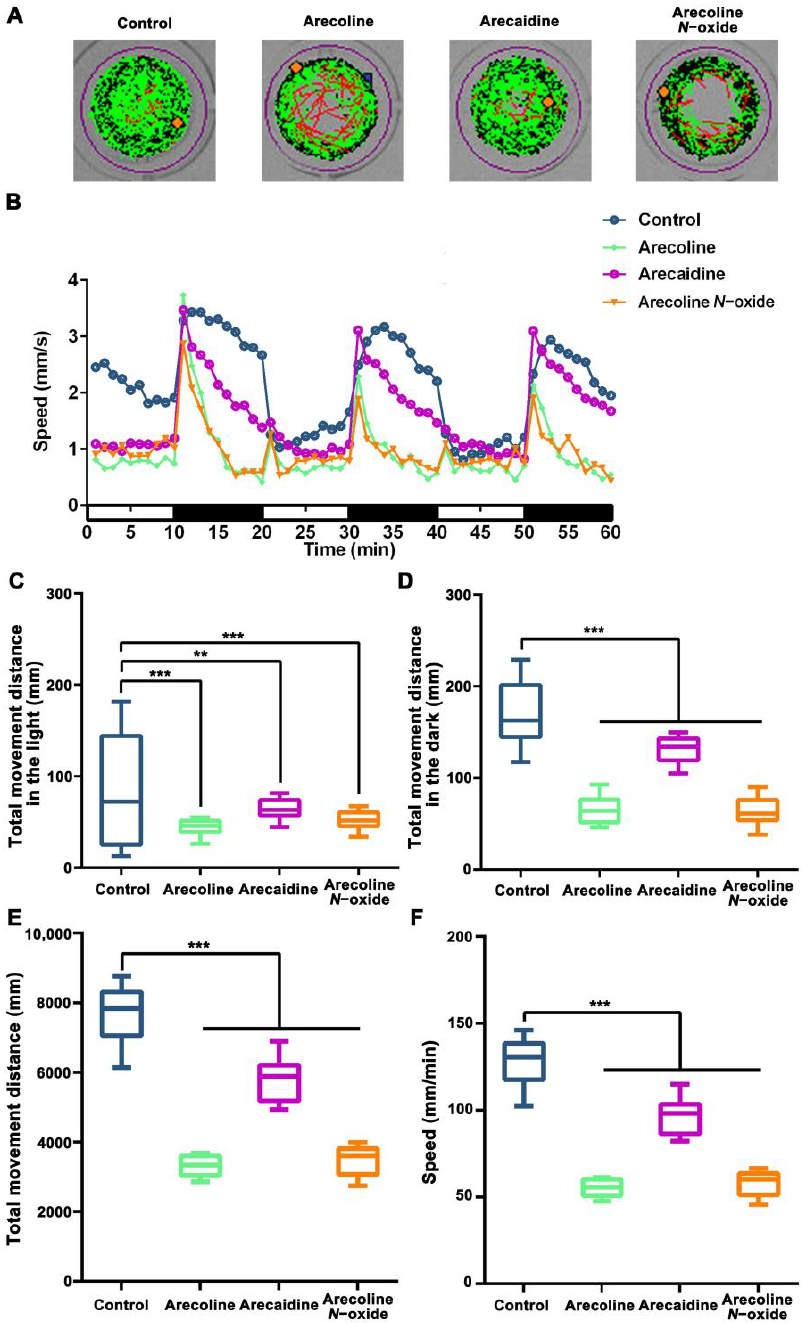
Figure 4. Effect of areca alkaloid exposure on the motor nervous system in zebrafish larvae at 96 hpf. ( A ) Representative trajectory traces of zebrafish larvae treated with areca alkaloids (10 µ M